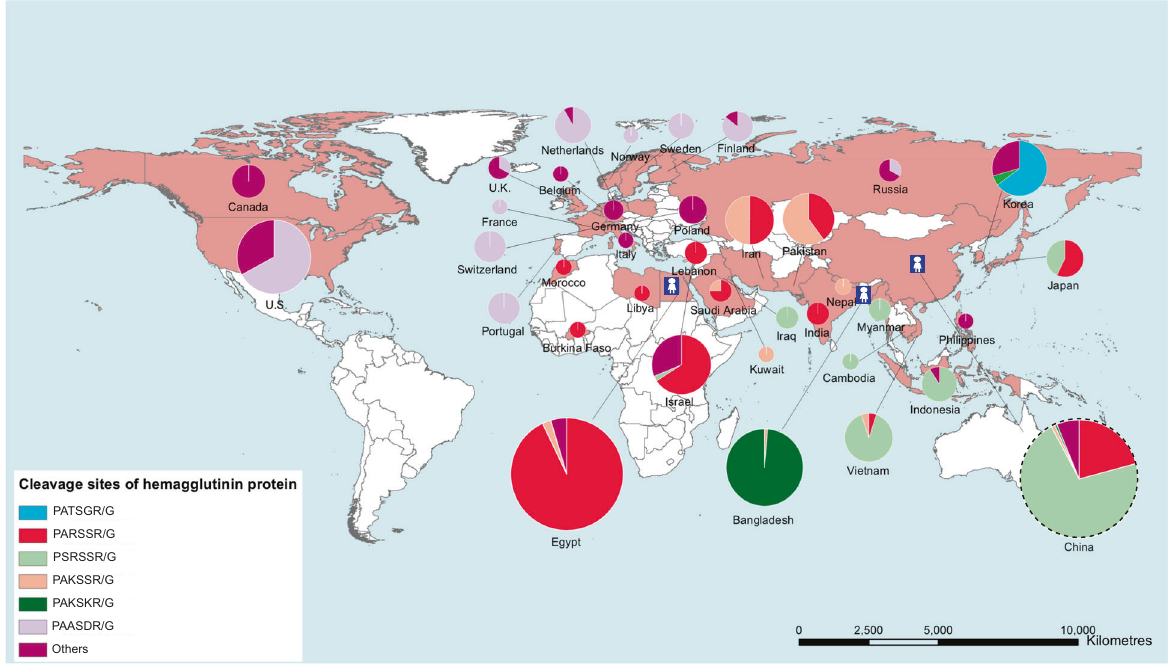
Fig. 2 Geographic distributions of HACS of global in fl uenza A(H9N2) viruses. Locations of human infections with H9N2 viruses are indicated by the blue cartoon fi gure. In the pie charts, the size represents the number of H9N2 isolates, and the colors represents different motifs of HA cleavage sites (HACS). The size of the dotted pie chart does not represent the number of H9N2 isolates in China owing to a large quantity of strains. Data are available from the GISAID ’ s EpiFlu Database, GenBank Database, the World Health Organization, the World Organisation for Animal Health, and the National Health and Family Planning Commission of the People ’ s Republic of China. The map was designed using ArcGIS Desktop 10.4 software (http://www.esri.com/